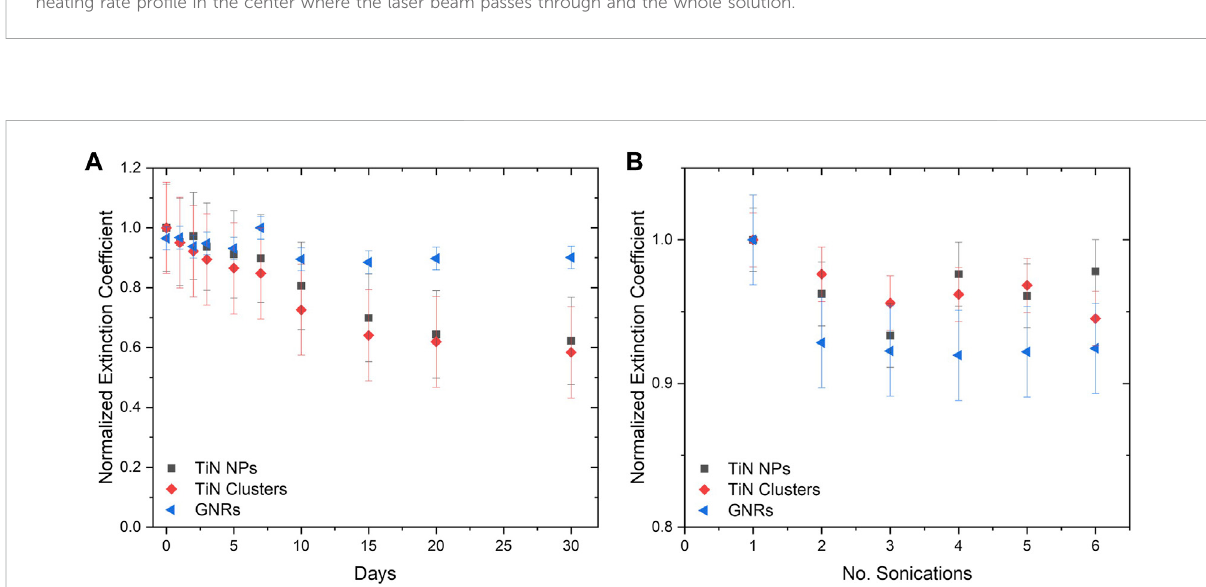
FIGURE 6 Nanomaterialcolloidalstabilitydeterminedbyextinctioncoef fi cient. (A) Theextinctioncoef fi cientfor30 daysdemonstratingthestabilityofTiN NPs and clusters in comparison to GNRs. (B) The extinction coef fi cient after a certain amount of sonication ’